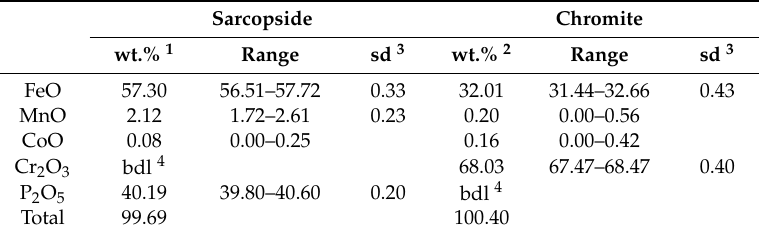
1 Average of 18 analyses on 6 grains. Empirical formula recalculated on 8 oxygen atoms per formula unit: